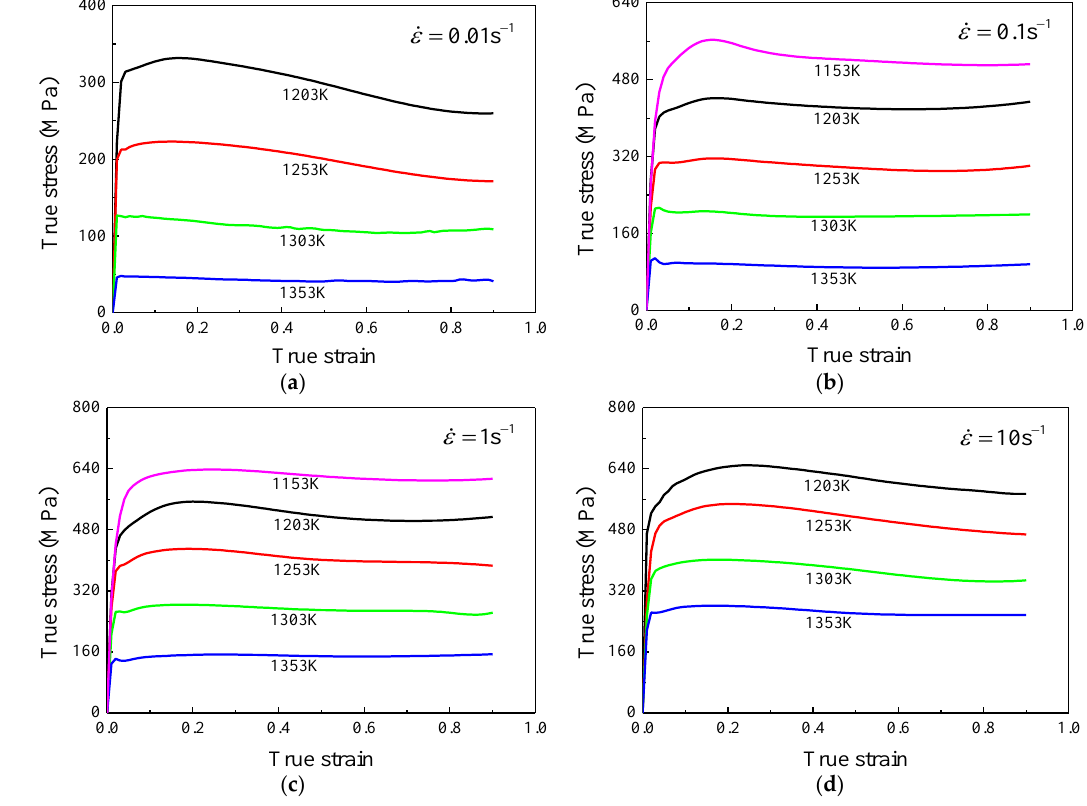
Figure 3. The stress-strain curves of Inconel 718 superalloy under different temperatures with the strain rates of ( a ) 0.01 s −1 ; ( b ) 0.1 s −1 ; ( c ) 1 s −1 and ( d ) 10 s −1 .